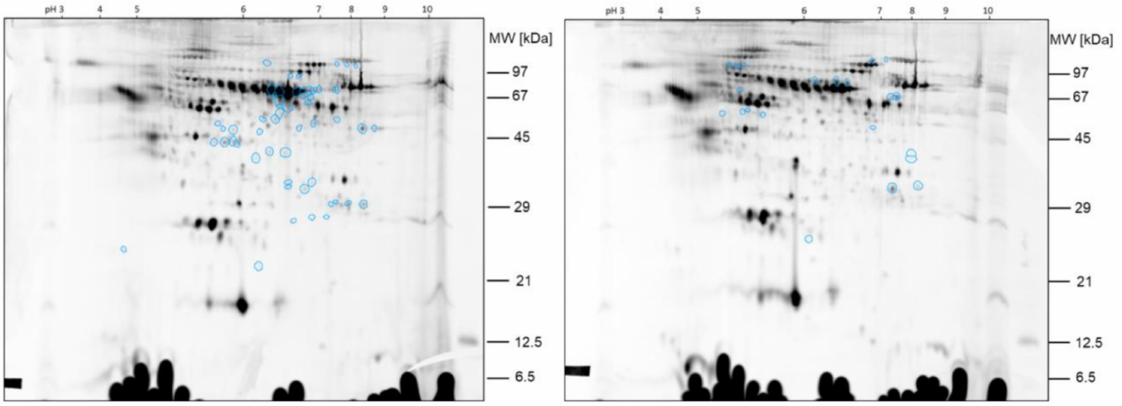
Figure 10. Comparison 3: Spots found >2-fold higher expressed in sample hypobaric hypoxia 60 min ( left ) versus >2-fold higher expressed in sample hypobaric hypoxia 30 min ( right